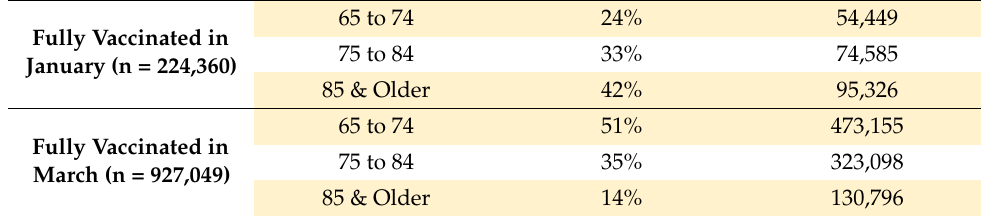
Table 2. Age Distributions of January & March Vaccinee